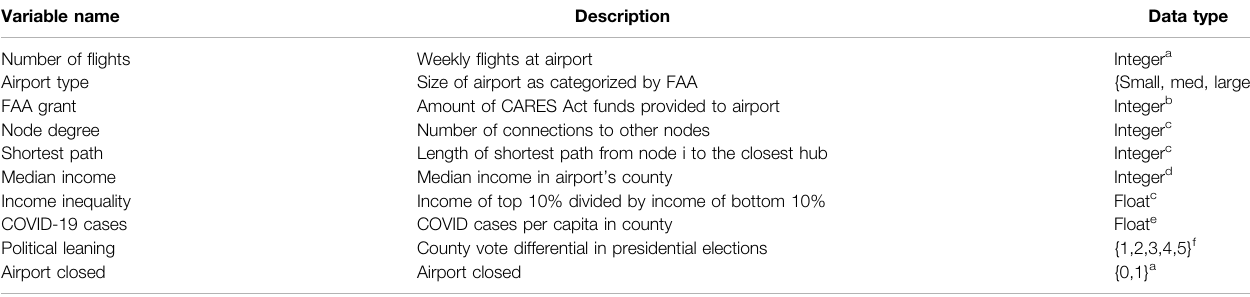
TABLE 1 | Variables in random forest